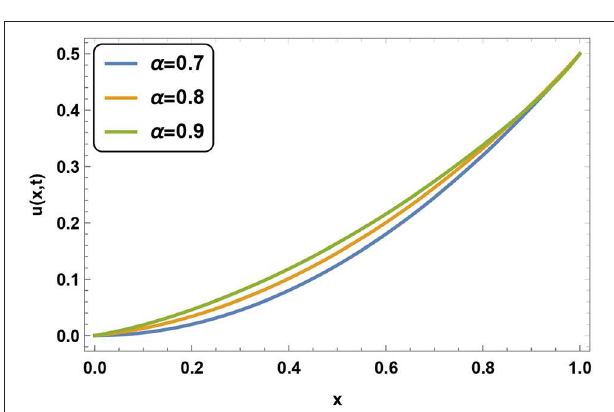
FIGURE 3 | Plots of u at time t = 0.1 for m = 4 at different value of α